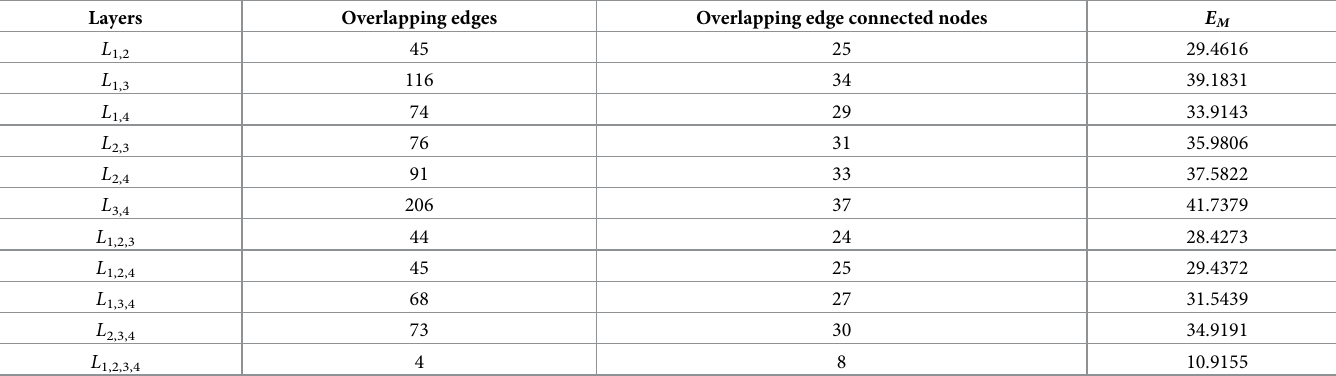
Table 4. Structure entropy of overlapping links between layers of tailor shop multiplex network.